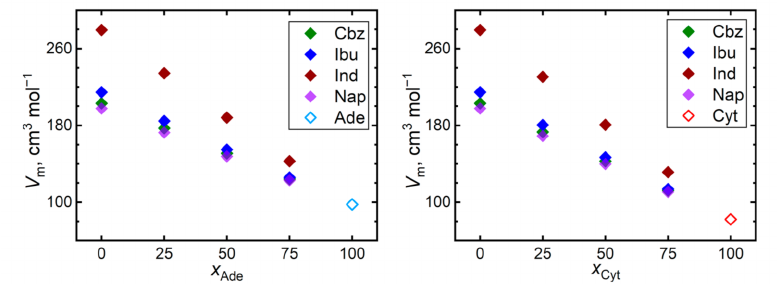
Figure 4. Molar volumes of mixtures of the nucleobases (adenine, Ade—left; and cytosine, Cyt— right) with API (carbamazepine, Cbz; RS-Ibuprofen, Ibu; Indomethacin, Ind; and naproxene, Nap) at 410 K.